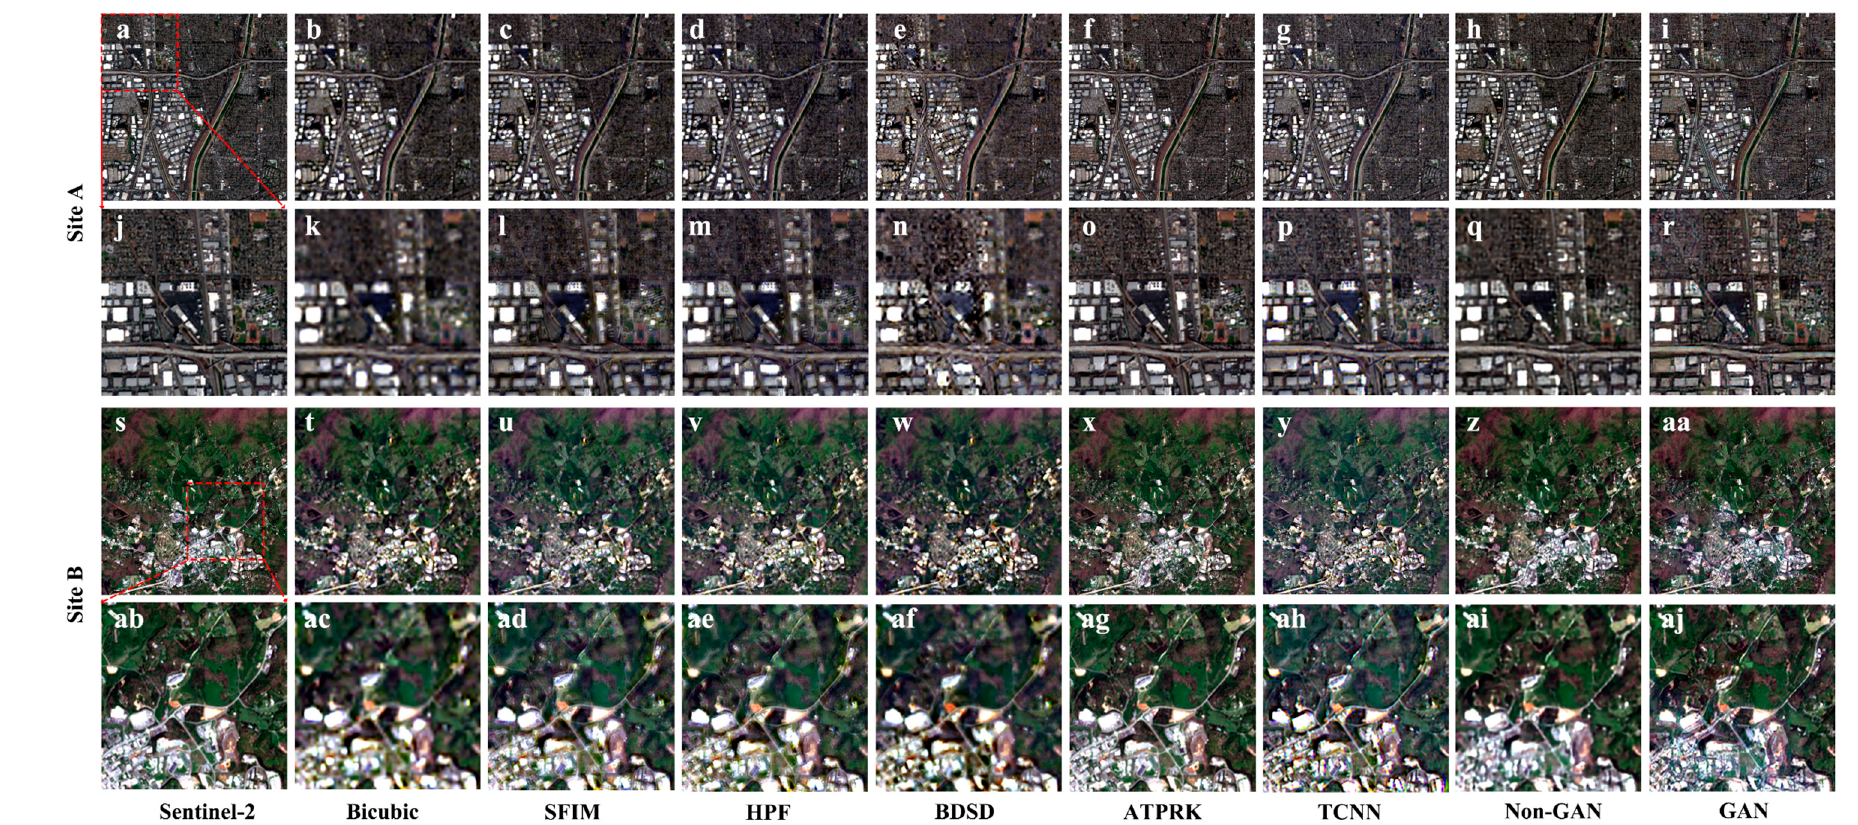
Figure 7. Super-resolution results in the real data experiment. From left to right: original Sentinel-2, interpolated, smoothing filter based intensity modulation (SFIM) derived, high pass filtering (HPF) derived, band-dependent spatial-detail (BDSD) derived, area-to-point regression kriging (ATPRK) derived, target-adaptive CNN-based (TCNN) derived, non-GAN derived, and GAN derived images at the site A ( a – r ) and site B ( s – aj ). For site A, ( j – r ) are shown as the zoomed-in comparison of ( a – i ); for site B, ( ab – aj ) are shown as the zoomed-in comparison of ( s – aa ).